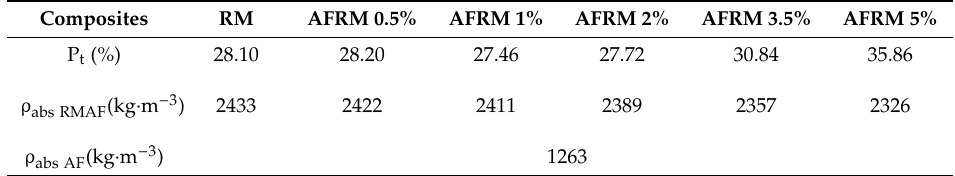
Table 3. Required parameters for thermal conductivity prediction.